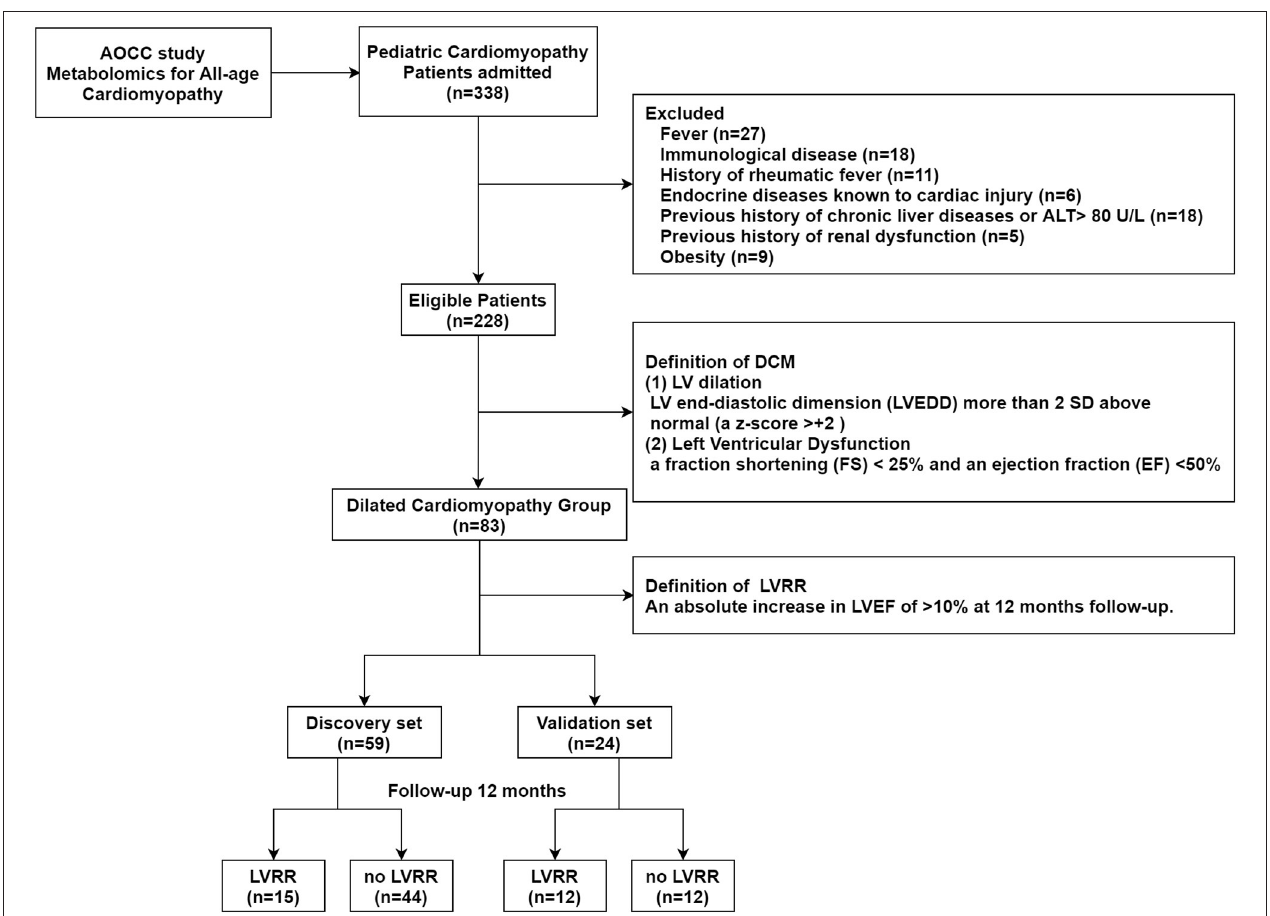
FIGURE 1 | Study flow. The study population enrolled from the China-AOCC (an integrative-omics study of cardiomyopathy patients for diagnosis and prognosis in China) study was divided into discovery and validation sets. LV, left ventricular; LVRR, left ventricular reverse